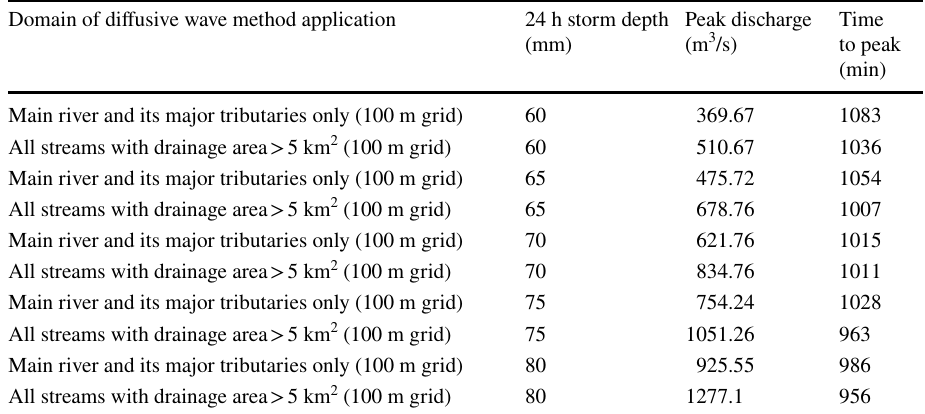
Domain of diffusive wave method